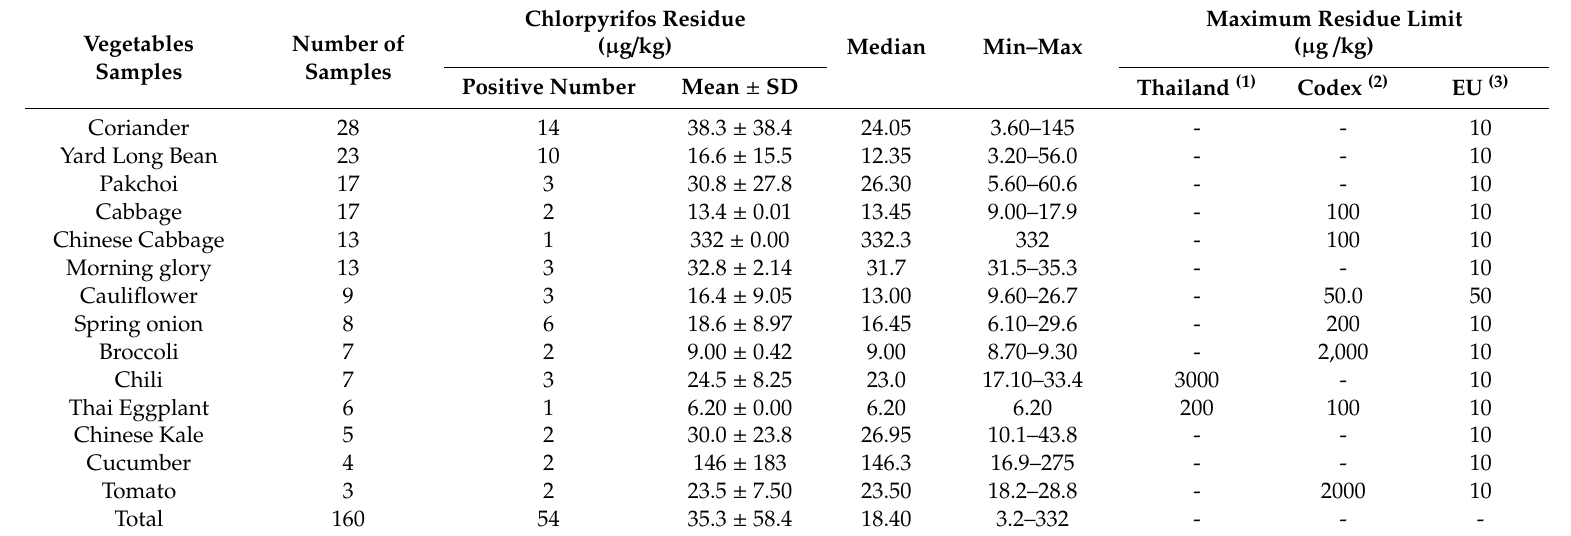
Table 3. The chlorpyrifos residue in vegetable samples from northern